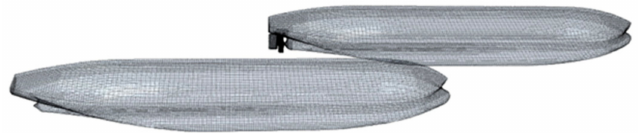
Figure 4. Mesh on the hull surface of the